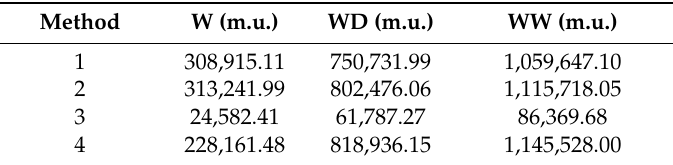
Table 9. Remuneration Comparison.